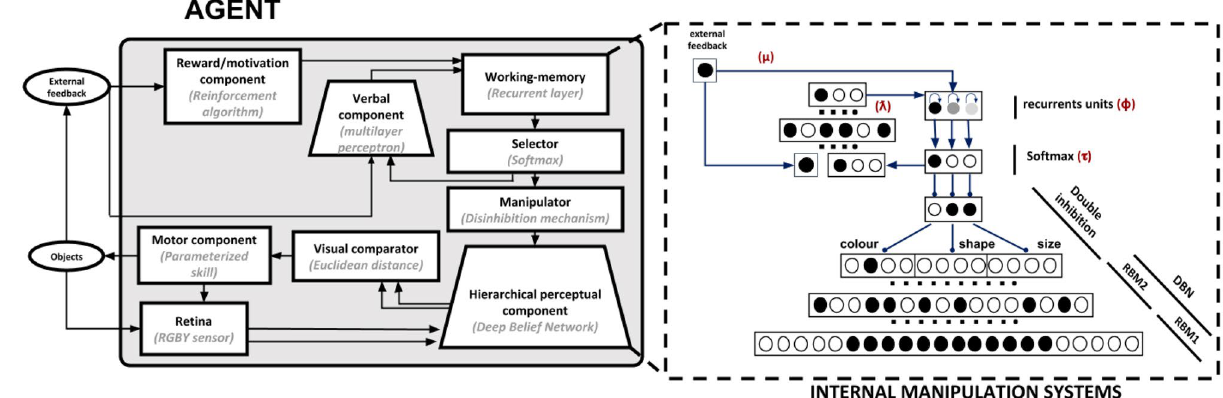
Figure 2. Architecture of the model. Left: components of the model. Right: zoom on the neural-network components of the model performing the internal manipulation of representations aided by the language component. The red symbols near the components identify model parameters important for specific cognitive functions (see text for